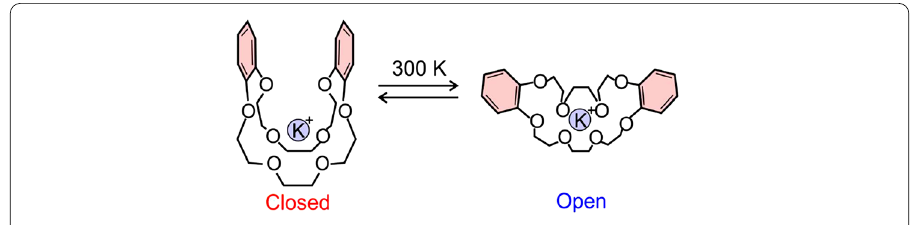
Figure 8 Isomerization reaction between closed and open conformers of K + (DB24C8) at 300 K